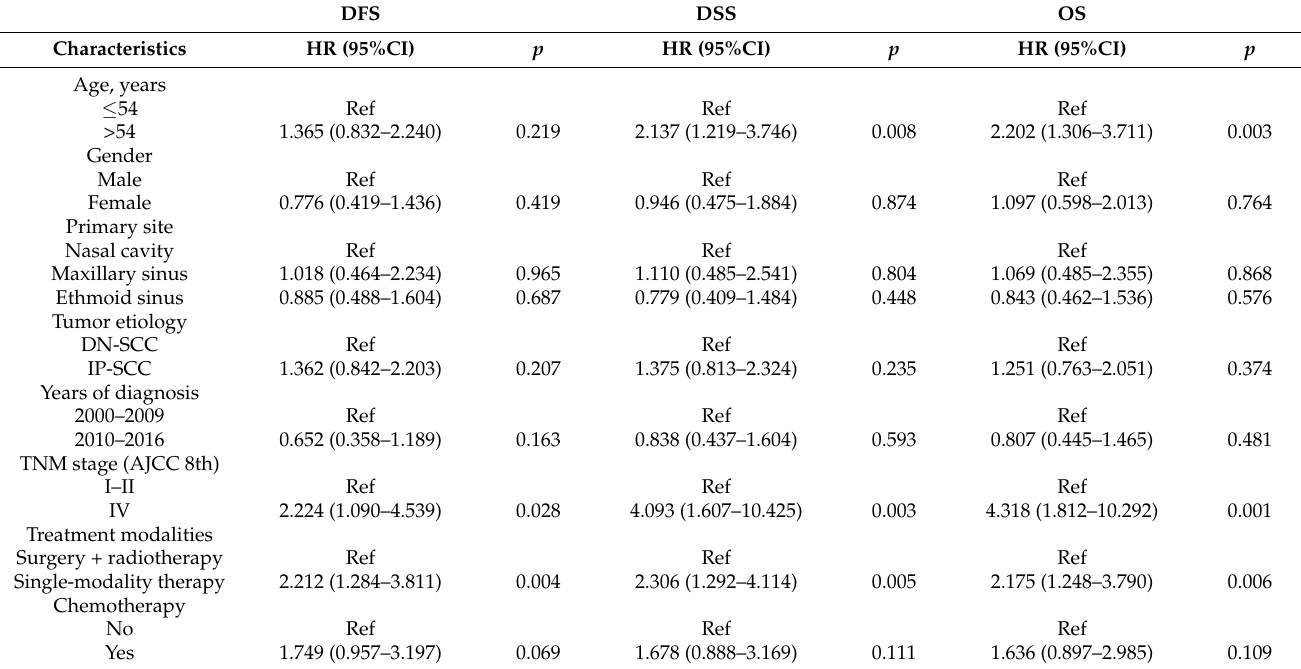
Table 2. Propensity score-matched Cox proportional hazards regression analysis of